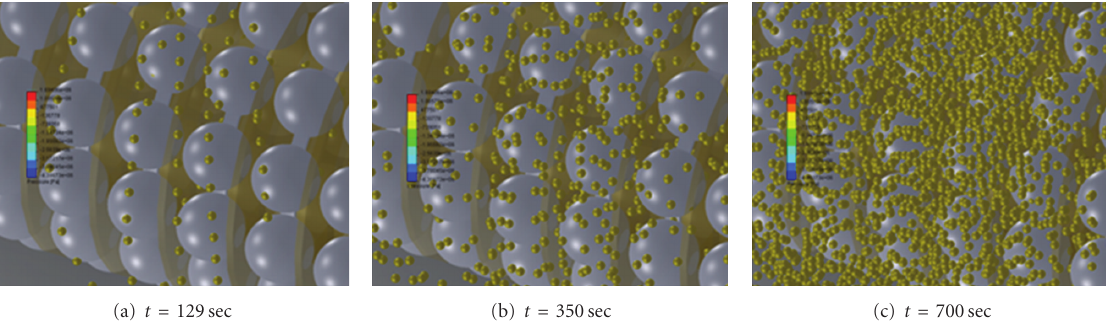
Figure 15: Concentration profiles for c and q at di ff erent times in a column filled with 100 silica gel beads.